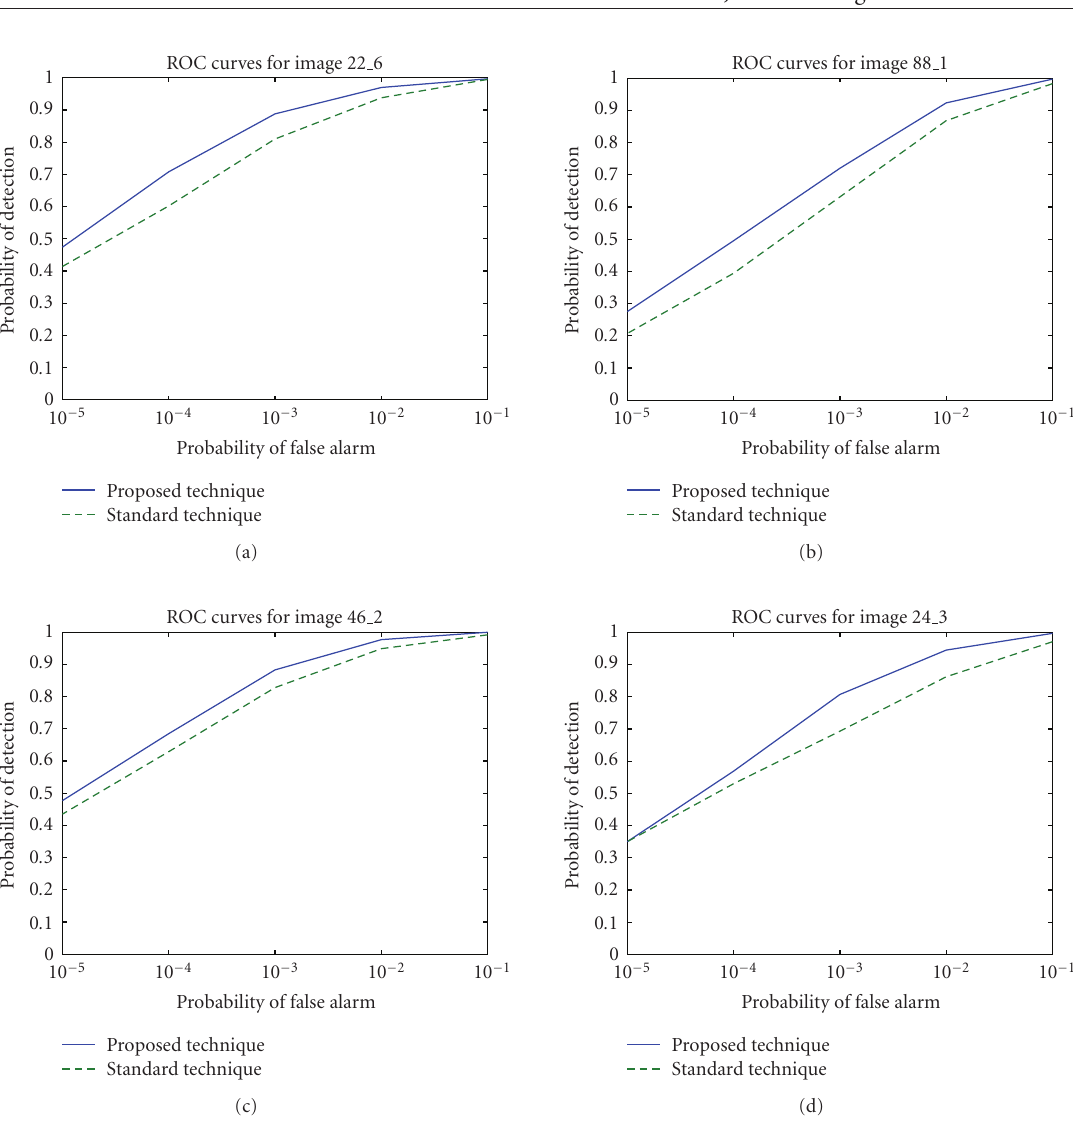
Figure 6: ROC curves of test images. Watermarking applied in the DWT domain. Strength λ = 0 .